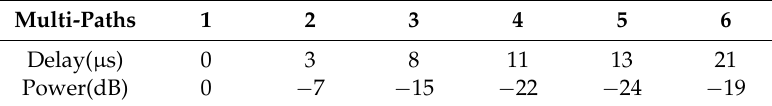
Table 1. IEEE 802.22 channel profile.